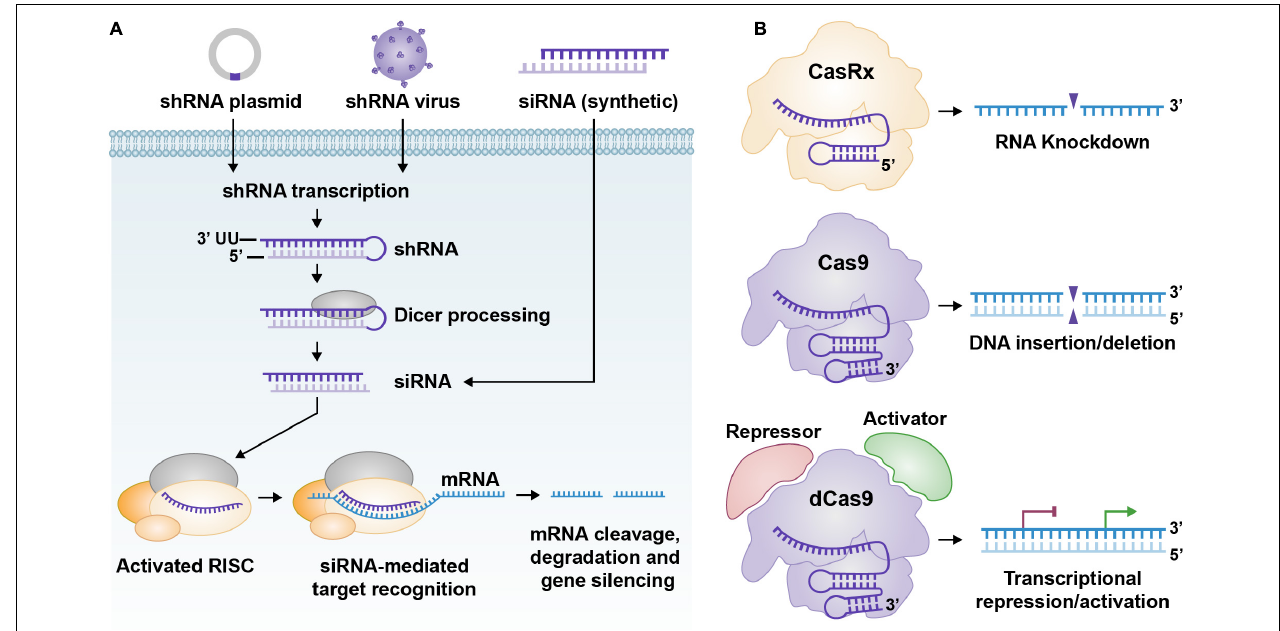
FIGURE 1 | (A) General pathway for shRNA and siRNA; from delivery to processing. ShRNA expression cassettes are usually delivered to cells via DNA plasmids or recombinant viruses. Once the shRNA expression cassettes reach the cell nucleus, they can undergo gene transcription. The shRNA, once transcribed, is processed via Dicer and produces a functional siRNA. Synthetic siRNAs can be delivered to cells too. The siRNAs bind to the RISC complex and their target RNA and cleave their target RNA, which renders the RNA inactive. (B) Three graphical representations of common CRISPR technology. From top to bottom. CasRx (Cas13d)/gRNA complex can target specific RNAs for cleavage/destruction. Cas9/gRNA complex can bind to DNA and cleave it. This creates an insertion or deletion after the cell’s DNA repair machinery attempts to fix the DNA double-strand break. dCas9 fused to a transcriptional repression or activation domain (CRISPRi/a) complexed with a gRNA can reduce or enhance transcription of the target gene,